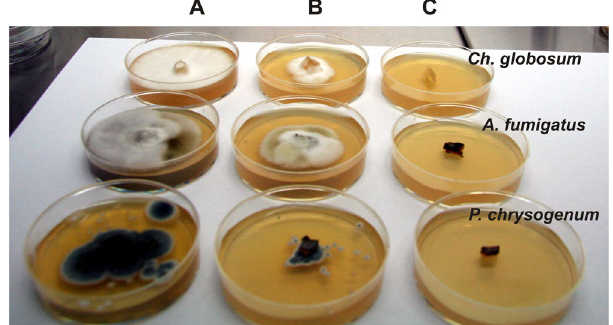
Figure 4. Mycelial growth inhibition of thyme essential oil vapor at different concentrations against Chaetomium globosum , Aspergillus fumigatus and Penicillium chrysogenum on a Malt Extract agar plate. ( A )